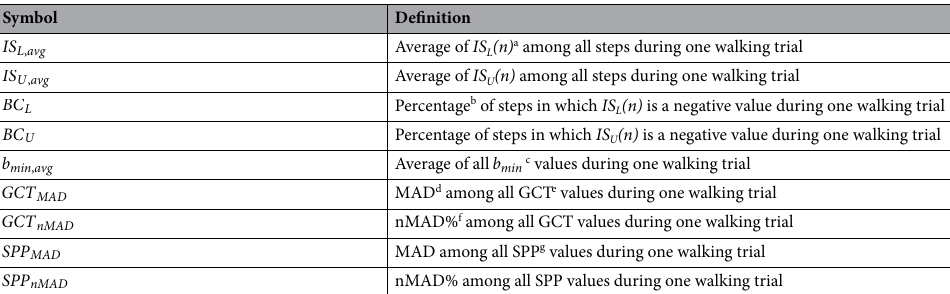
Table 1. List of our proposed measures of stability and their associated parameters as well as previously introduced measures of stability. Each parameter’s symbol and definition are presented. a n is the step number index. IS L (n) (or IS U (n) ) is the minimum distances between the lower (or upper) limit of ExFSR and COM state trajectory, during each step. b Percentage refers to the fraction of steps (out of all steps of a walking trial) in which IS(n) had a negative value. c b min is the minimum distance between the XCOM and BOS boundaries during each step. d MAD indicates the Median Absolute Deviation of parameter X among all steps of a walking trial: MAD ( X ) = med ( | X − med ( X ) | ) (see 24 ). e GCT indicates the gait cycle time. f nMAD% indicated the MAD normalized to the median value: nMAD % = 100 × MAD / med (We introduced nMAD% as a robust alternative to the coefficient of variation). g SPP indicates the swing phase